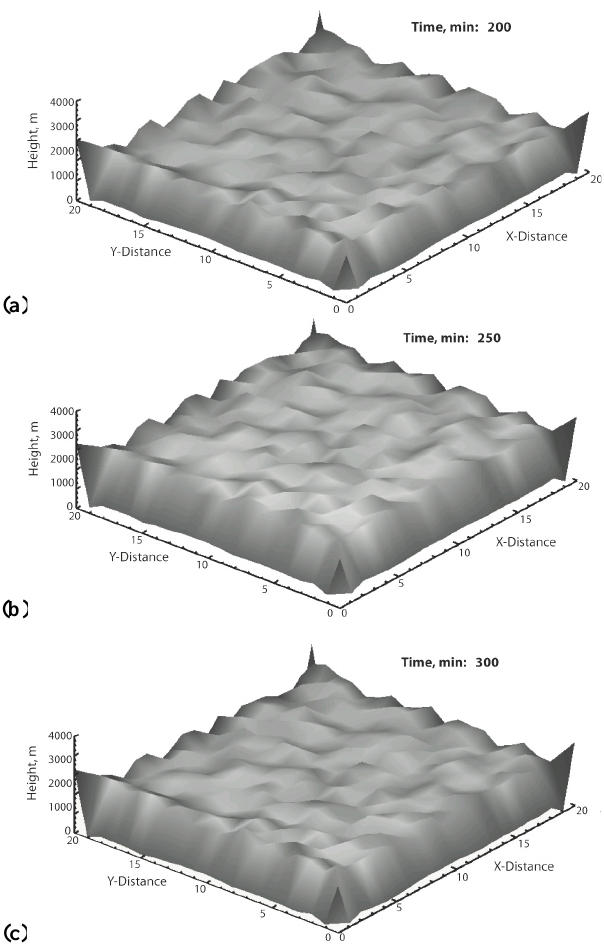
Fig. 11. Snapshots of model output associated with Fig. 10 at (a) 200min, (b) 250min, and (c) 300min. Horizontal axes are x and y distances (or grid number i , j ). Vertical axes are height in m. Note the temporal invariance of the